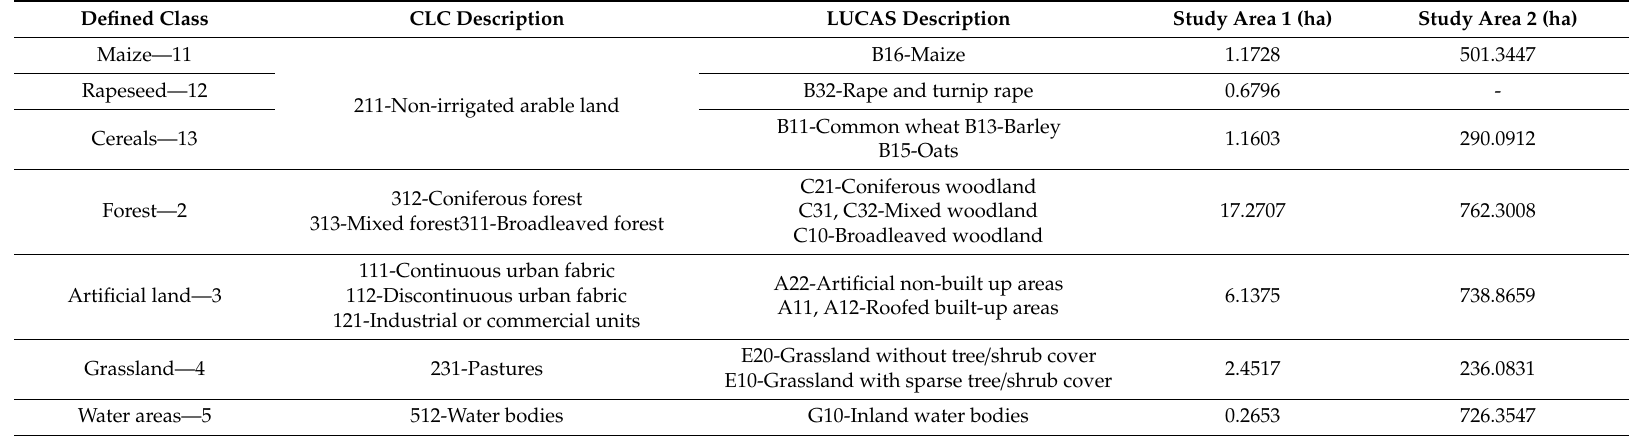
Table 1. Redefining classes combining CORINE Land-Cover (CLC) and European Land Use and Coverage Area Frame Survey (LUCAS), with the total sample area of each class for both study